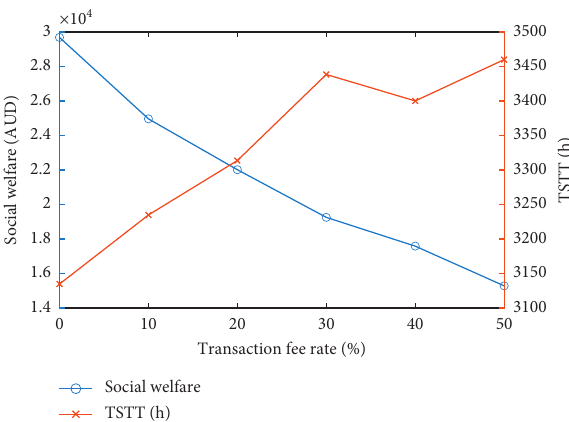
Figure 6: Social welfare and TSTT as functions of transaction fee